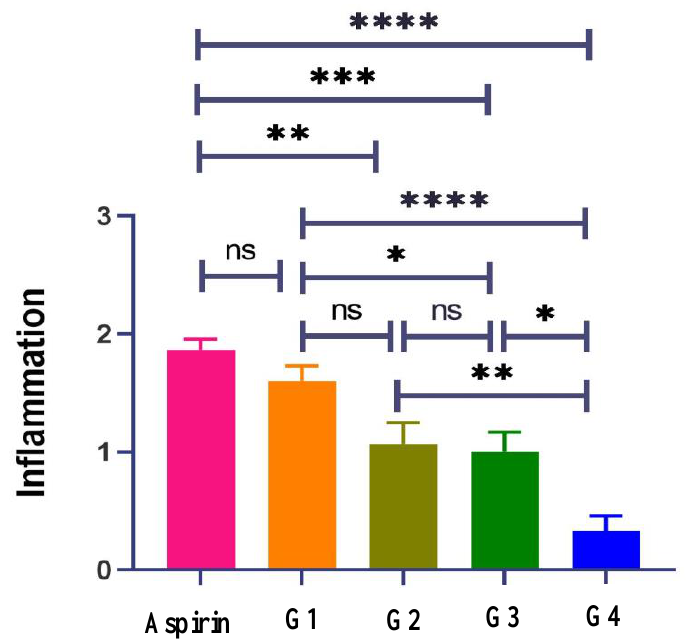
Figure 21. Inflammation score. Data were presented as means ± SE. * statistically significant at p ≤ 0.1,